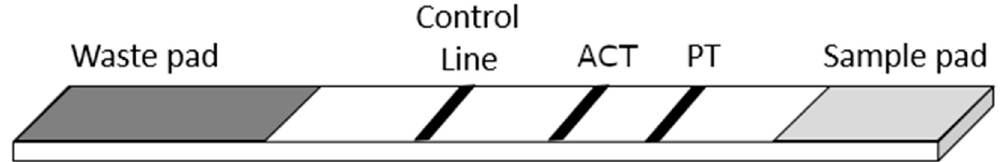
Figure 1. The layout of the multiplex lateral flow test. Pertussis toxin (PT) and adenylate cyclase toxin (ACT) antigen test lines were absorbed on the nitrocellulose membrane, in respective order.